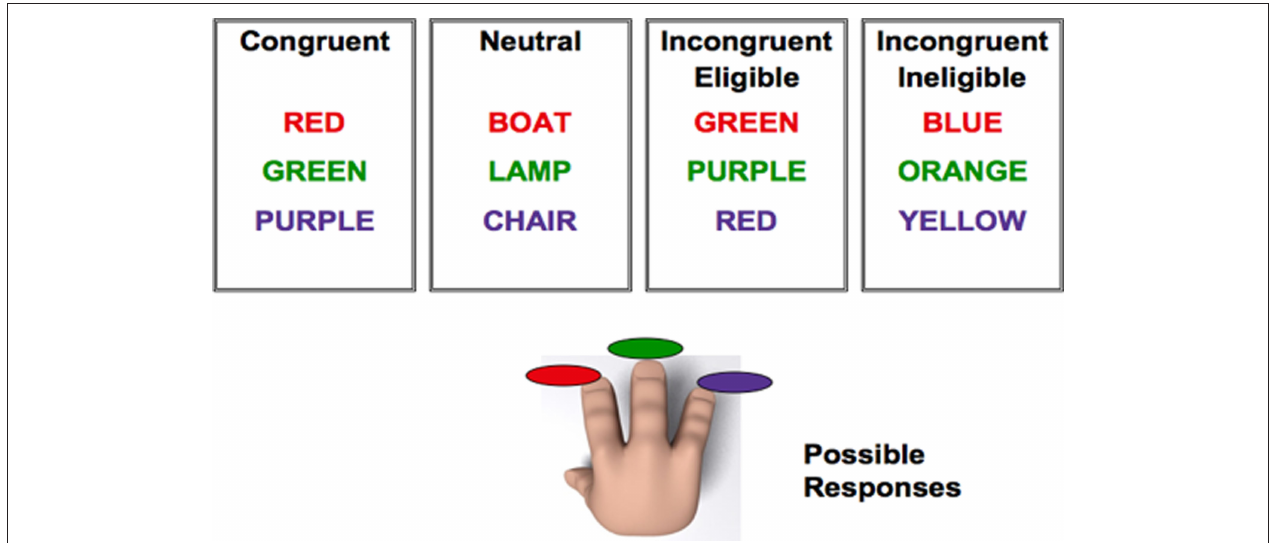
GREEN printed in red ink). For the incongruent-ineligible condition (fourth box), the word could be any color-word other than red, green, or purple printed in an incongruent ink-color (such as the word BLUE printed in red ink). Reprinted from Prakash et al. (2010a), Copyright (2010), with permission from